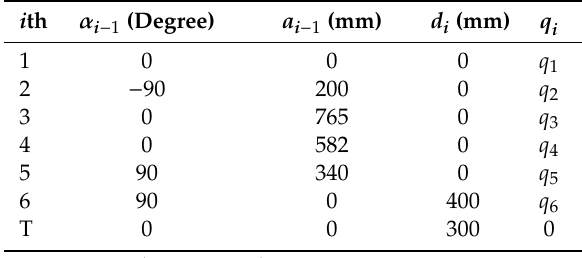
Table A1. The link parameters of the 6-DOF KIRO